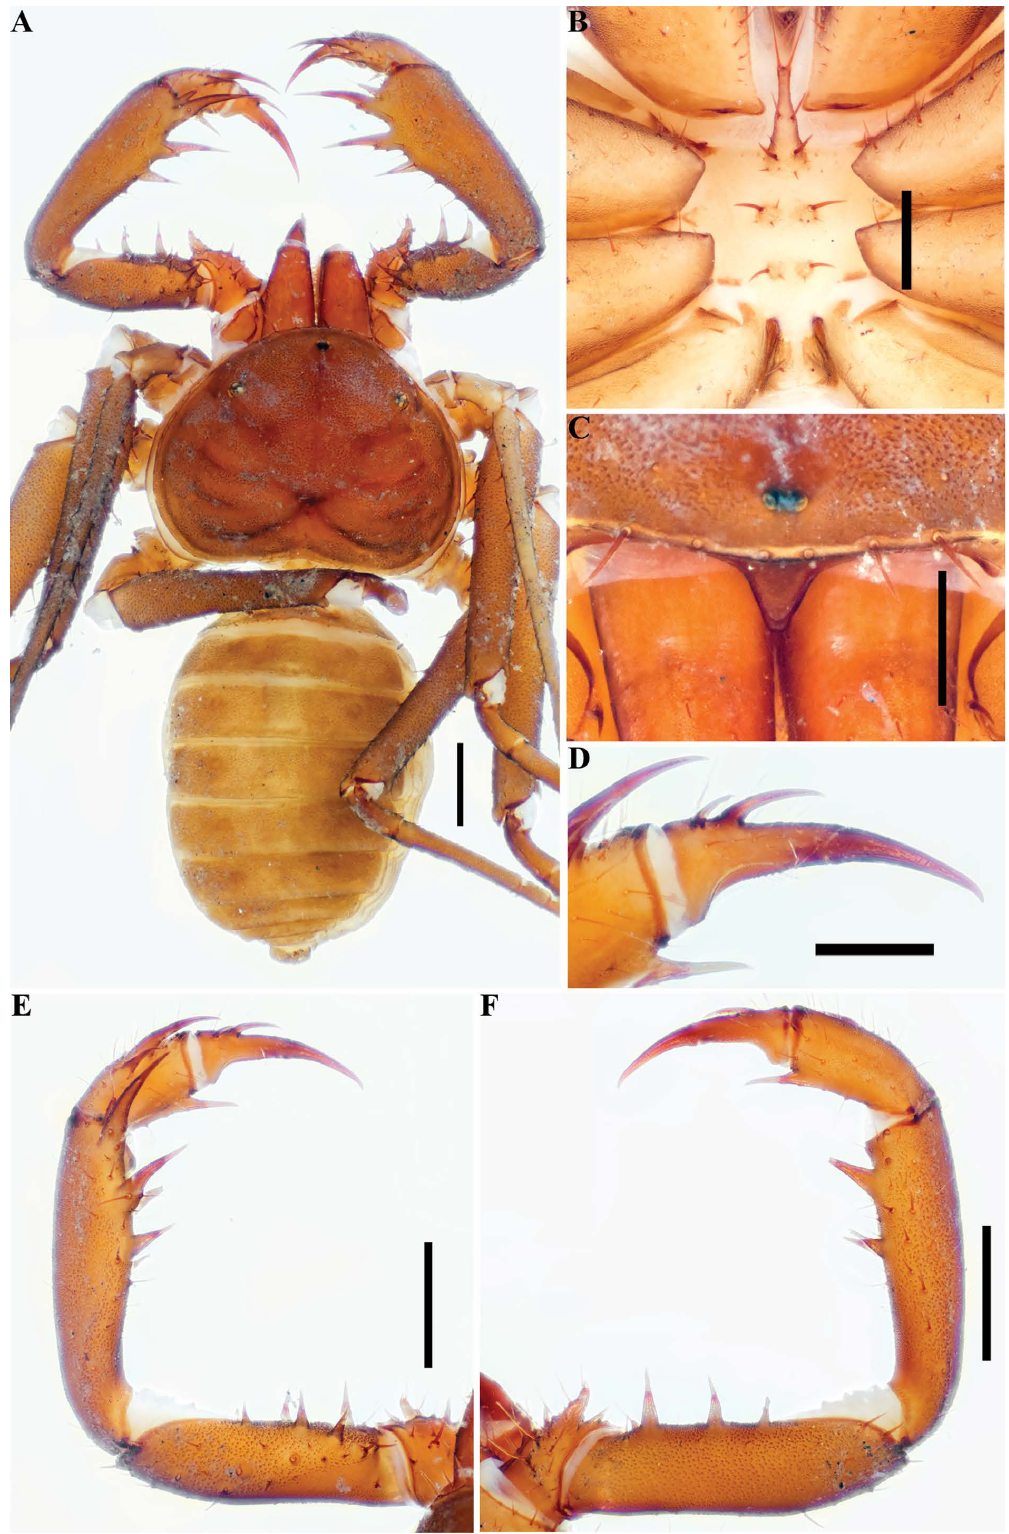
Fig. 24. Charinus miskito sp. nov. (SMNS), general morphology, ♀. A . Habitus, dorsal view. B . Frontal process. C . Sternum, ventral view. D . Pedipalp tarsus, frontal view. E . Pedipalp, dorsal view. F . Pedipalp, ventral view. Scale bars: A, E–F = 1 mm; B–D = 0.5